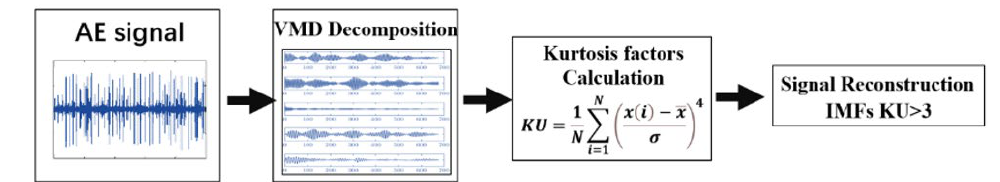
Figure 1. Flowchart of the VMD-kurtosis denoising method. First, VMD decomposition is applied to the acoustic emission (AE) signal to convert the signal into eight IMFs. Next, the kurtosis factor value of each IMF is calculated. Finally, the IMF with kurtosis factor > 3 is reconstructed.